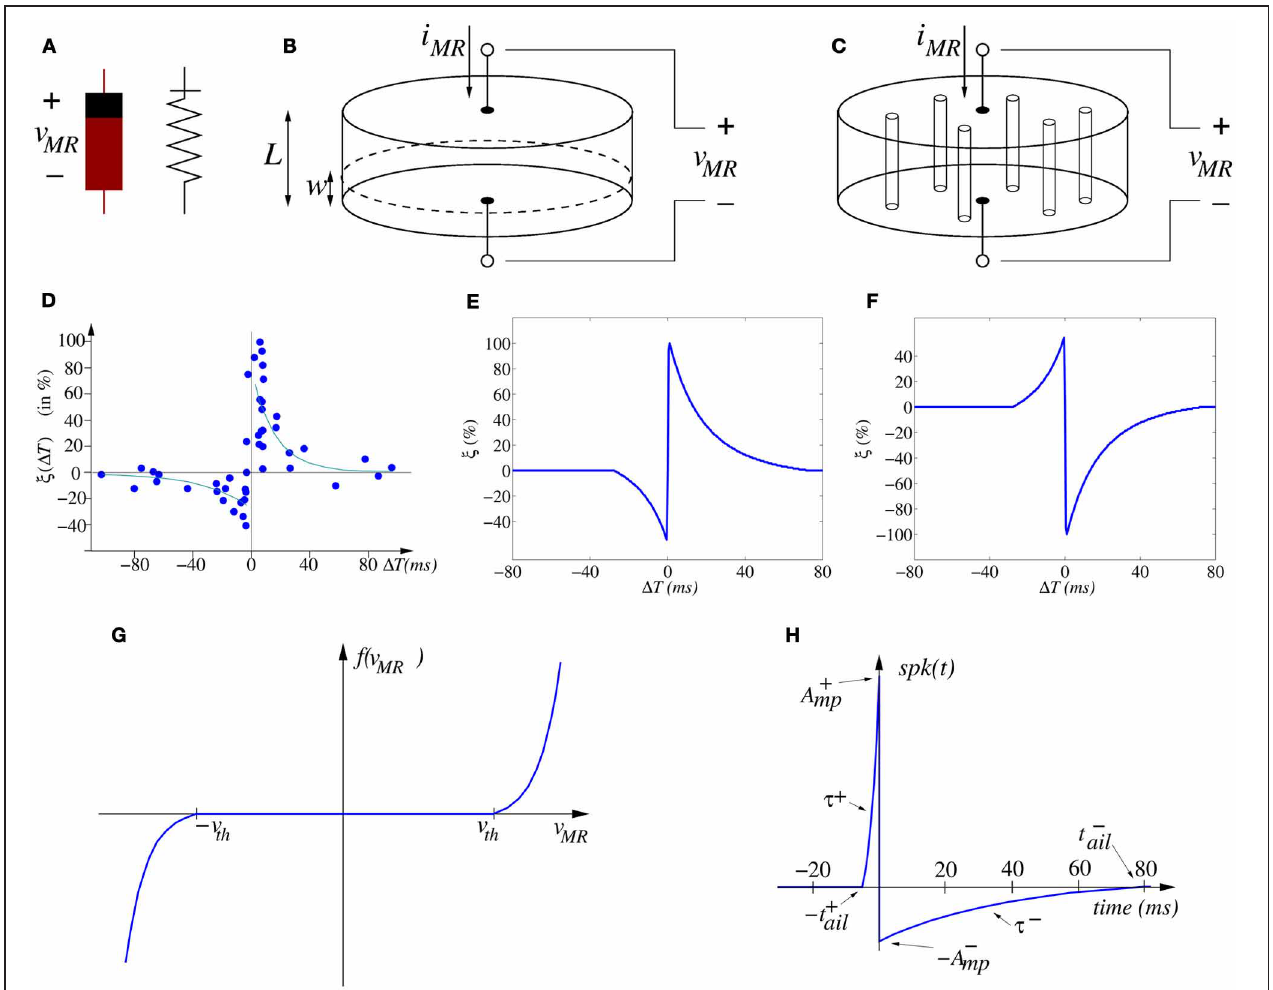
biological synapses (data from Bi and Poo, 1998, 2001). (E) Ideal STDP update function used in computational models of STDP synaptic learning. (F) Anti-STDP learning function for inhibitory STDP synapses. (G) Shape of memristor weight update function f ( v MR ) , (H) spike-shape